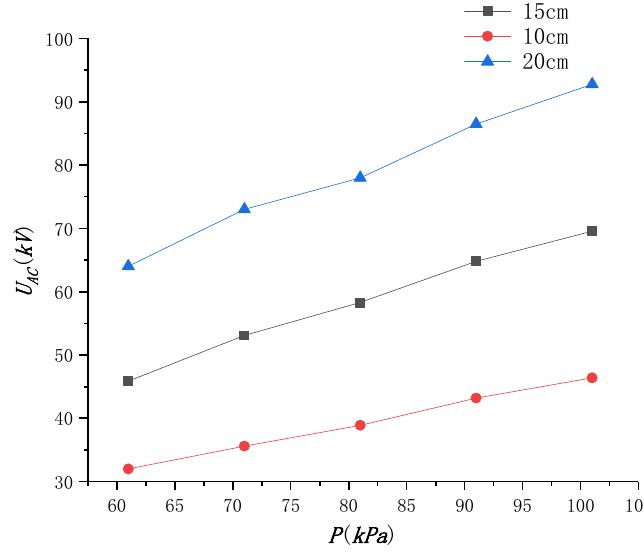
Figure 10. Gap breakdown voltage at different air pressures.